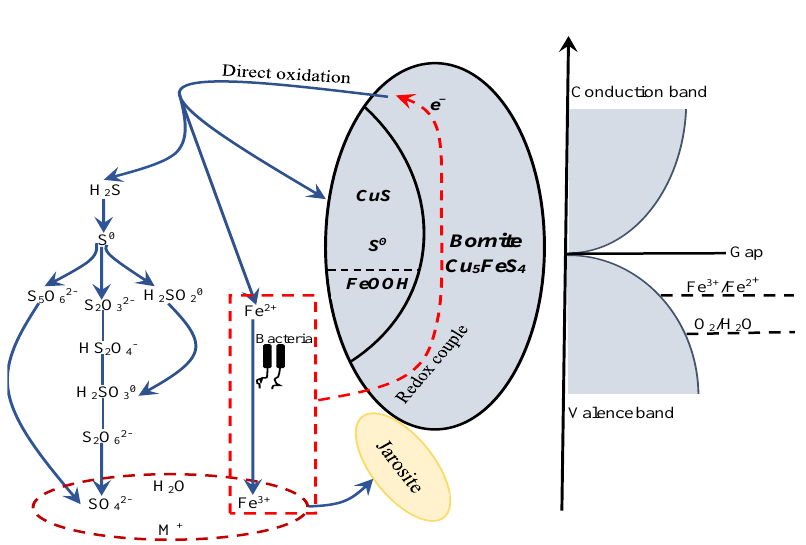
Figure 21. The proposed model for interpreting the dissolution process of bornite in bioleaching by moderately thermophilic microorganisms.